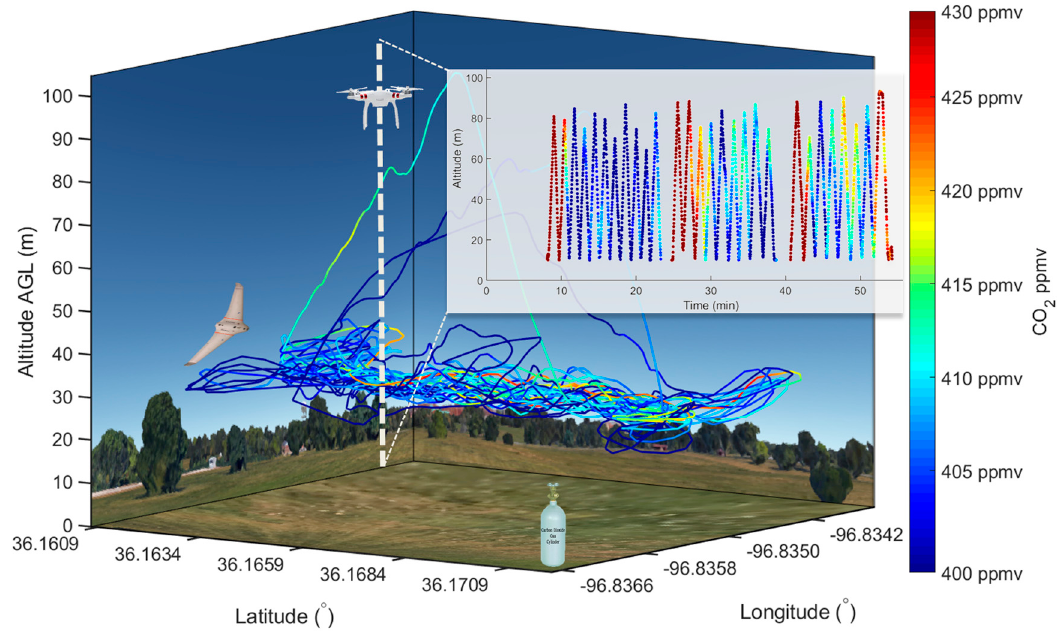
Figure 11. The horizontal and the vertical flights for the detection of induced leaks of CO 2 (released from the location of the cylinder) during 27 June, 2017 from 1:15 to 2:02 pm (UTC–5 h).